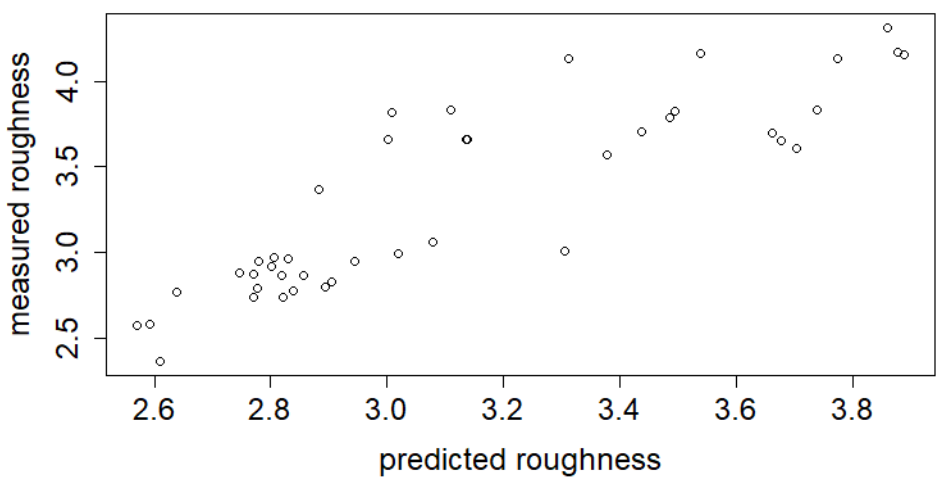
Figure 2. Scatter plot for predicted and actual values in test set for Model_RAP.